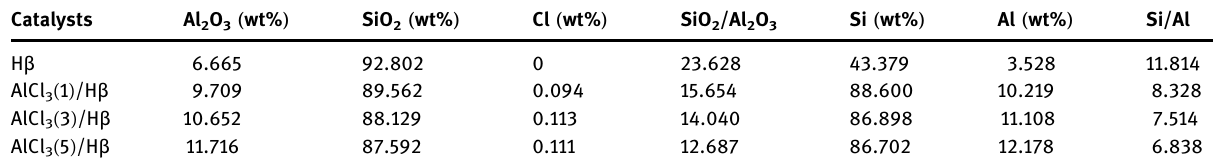
Table 4: Comparison of percentage content and ratio of AlCl 3 /H β catalysts supported by di ff erent concentrations of AlCl 3 Catalysts